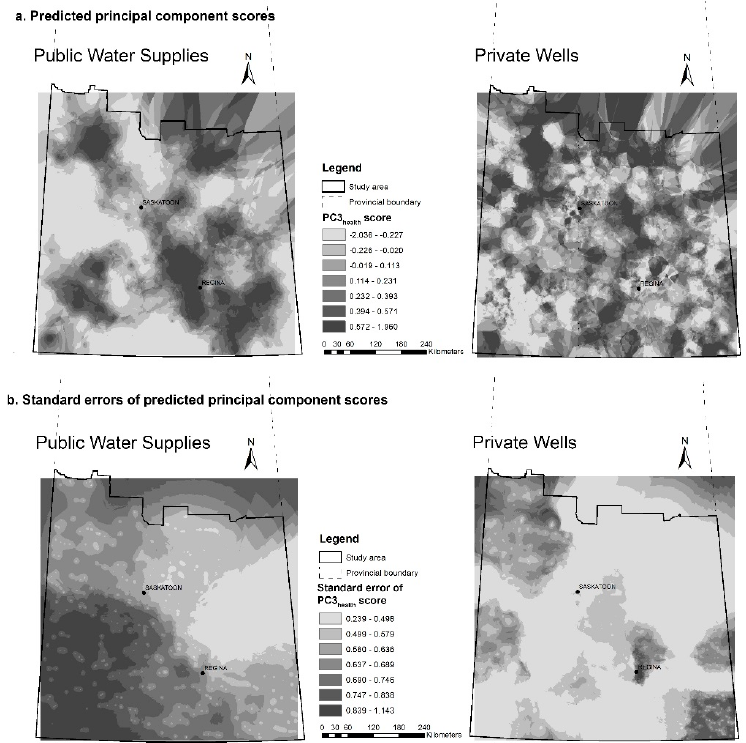
Figure A11. ( a ) Predicted PC3 health scores for public water supplies and private wells in study area; and ( b ) the corresponding prediction standard errors.